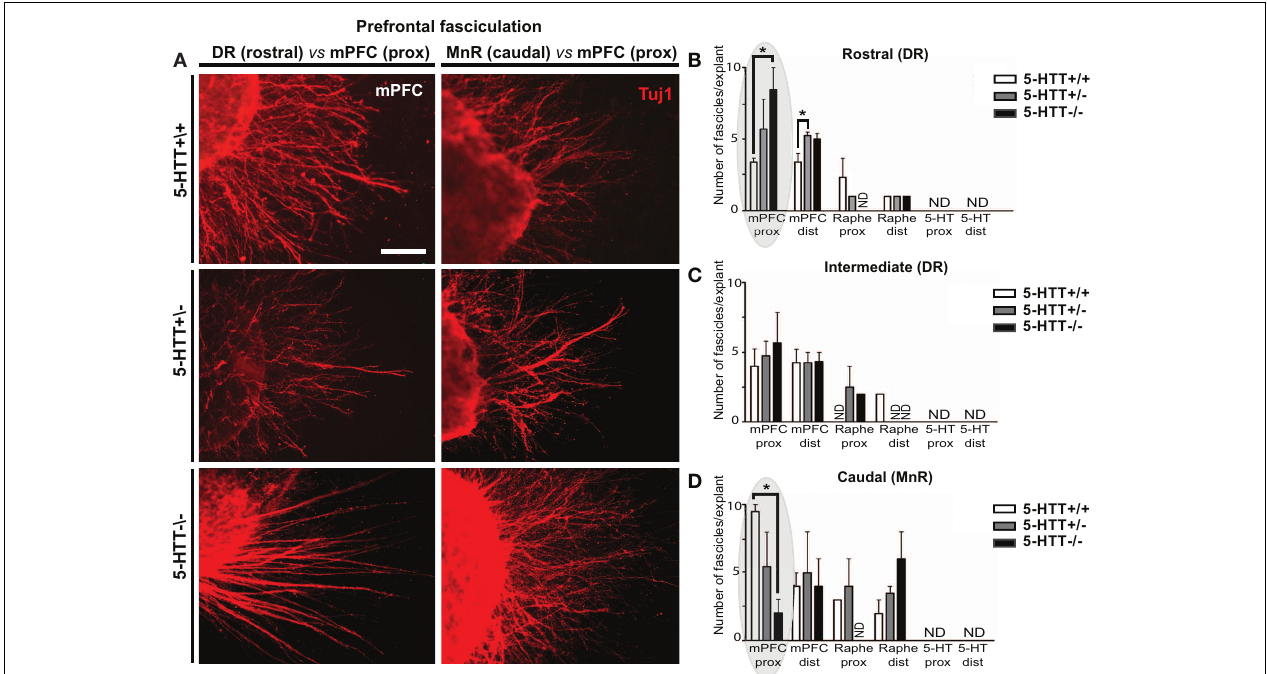
FIGURE 3 | The amount of 5-HTT during development influences mPFC fasciculation. (A) Examples of differences in number of fascicles per explant in WT, 5-HTT + / − and 5-HTT − / − mPFC (proximal quadrant) co-cultured with the rostral (DR, left panels) or caudal subarea (MnR, right panels). Scale bar represents 50 μ m. (B–D) Quantification of the number